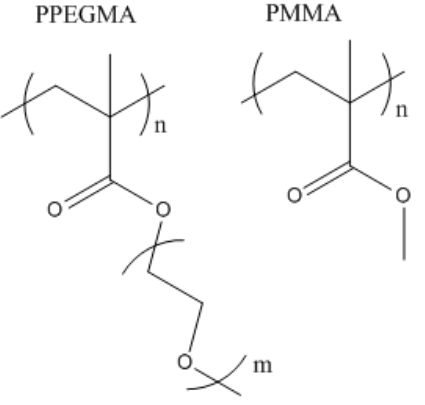
Figure 3. Chemical structure of poly-(poly(ethylene glycol) methyl ether methacrylate) (PPEGMA) and poly(methyl methacrylate)